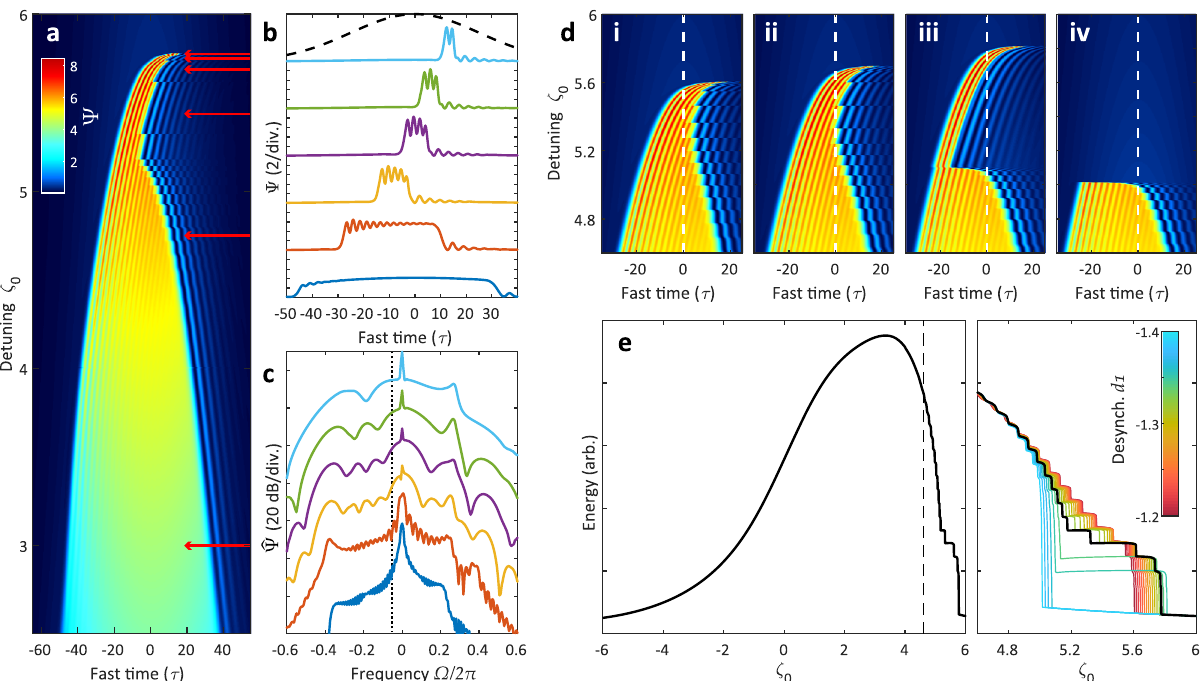
Fig. 3 | Simulation: zero-dispersion soliton formation via desynchronized pulse-driving. F 0 =10, d 2 =1, d 3 =1 a Intracavity fi eld as detuning ζ 0 is increased. d 1 = − 1.34 b Individual time domain and c frequency domain of the fi elds in a (red arrows). Pulse-drive envelope F ( τ ) marked by dashed line, and zero-dispersion frequency marked by dotted line, with normal dispersion on the righthand side.